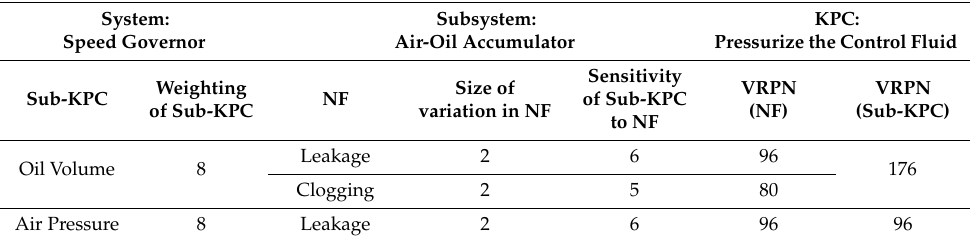
Table 15. VMEA form—air-oil accumulator example (brainstorming).